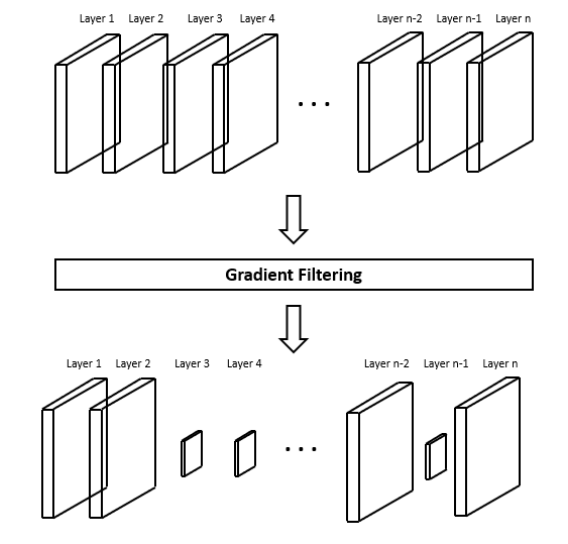
Figure 3. Changes of communication data size through layer